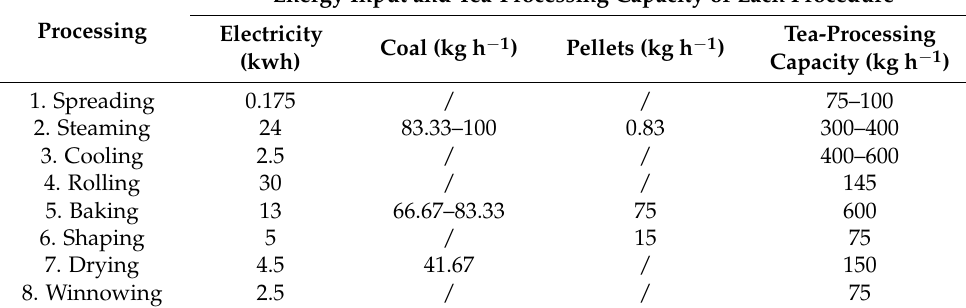
Table 2. Machining phase data sheet.